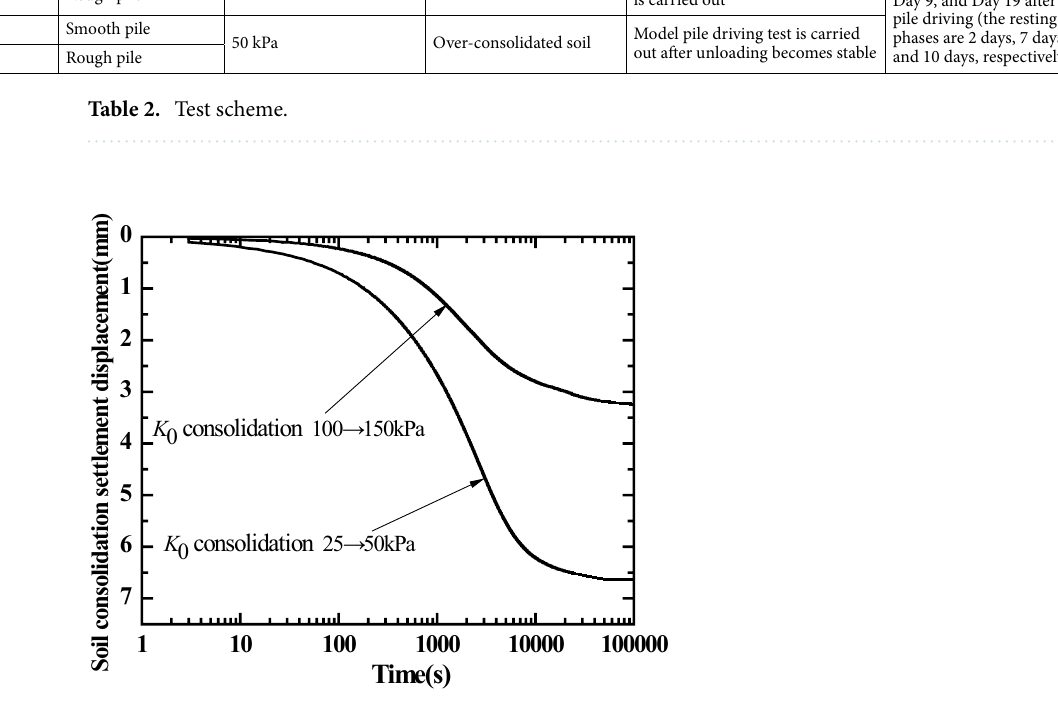
Figure 6. Curves for settlement displacement of soil K 0 consolidation with